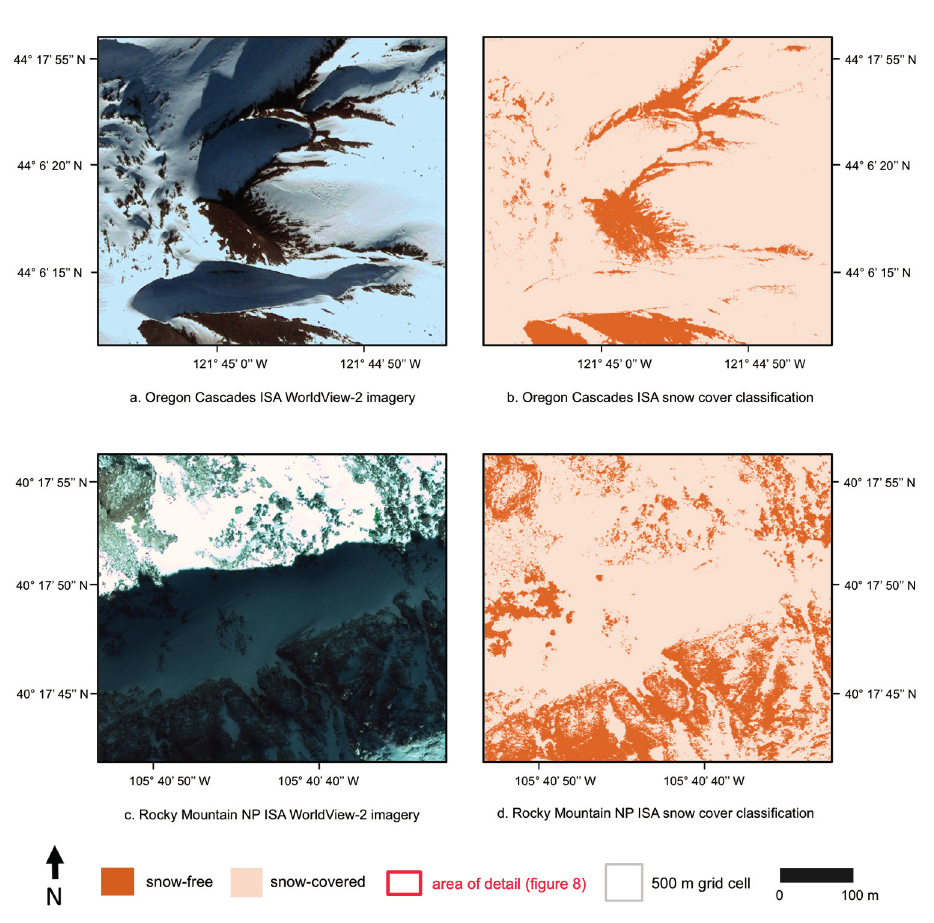
Figure 8. Examples of 0.5 m binary snow-covered area classifications ( right side ) based on WorldView 2 imagery ( left side ). Oregon Cascades, 26 December 2013, (panels a and b ) and Colorado Rocky Mountains, 26 February 2014 (panels c and d ).